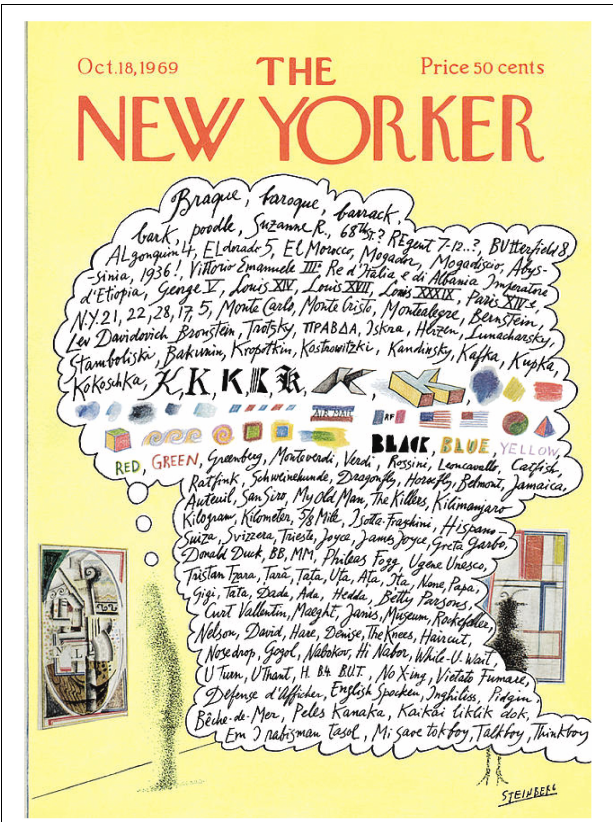
FIGURE 3 | Cover of New Yorker magazine with a cartoon by Saul Steinberg illustrating the diverse train of thought of a person viewing a cubist painting by Georges